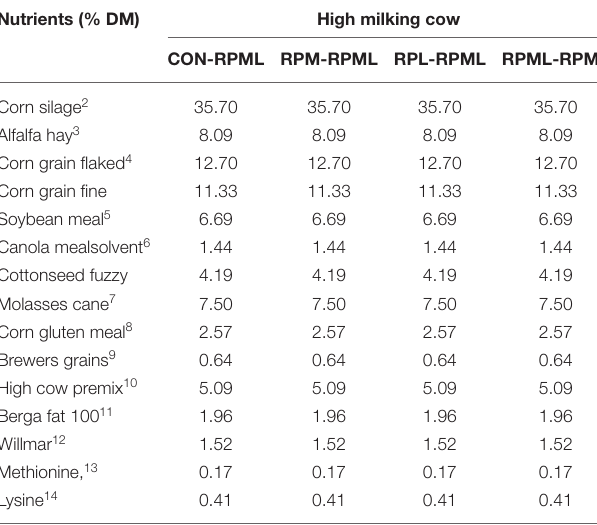
TABLE 2 | Chemical composition of the total mixed ration (TMR) fed to Holstein dairy cows during the High milking periods 1 . Nutrients (%